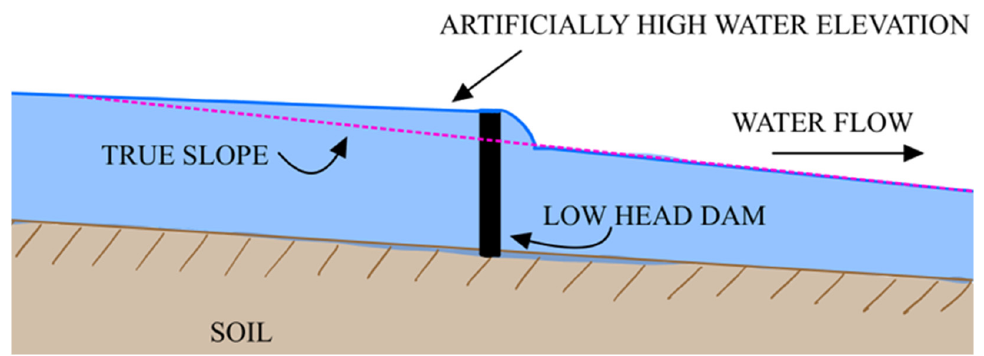
Figure 4. Elevation view of a potential error in water surface slope calculation.